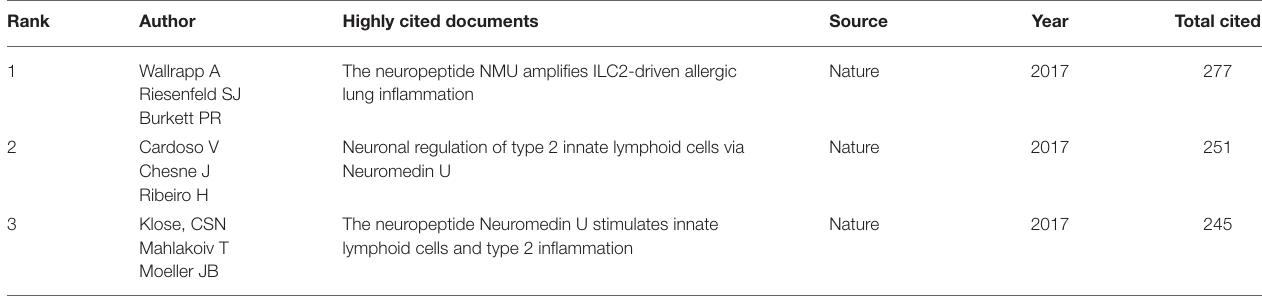
TABLE 4 | The list of highly-cited papers on NMU in the Web of Science database from 1987 to 2021. Rank